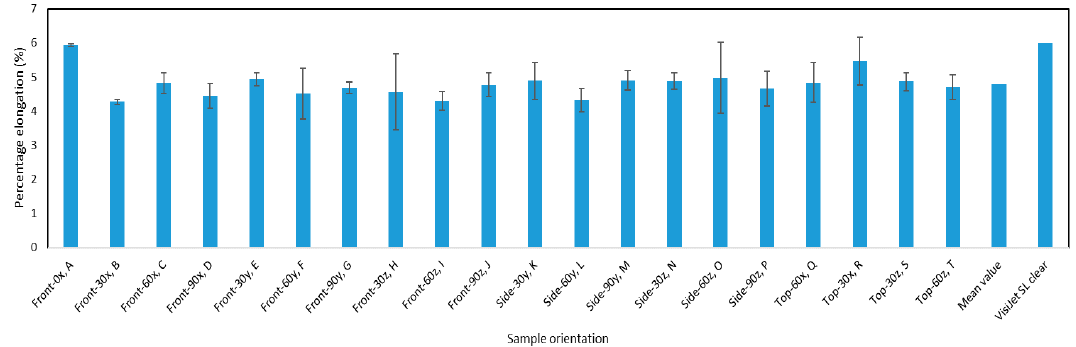
Figure 13. The percentage elongation for the different orientations.